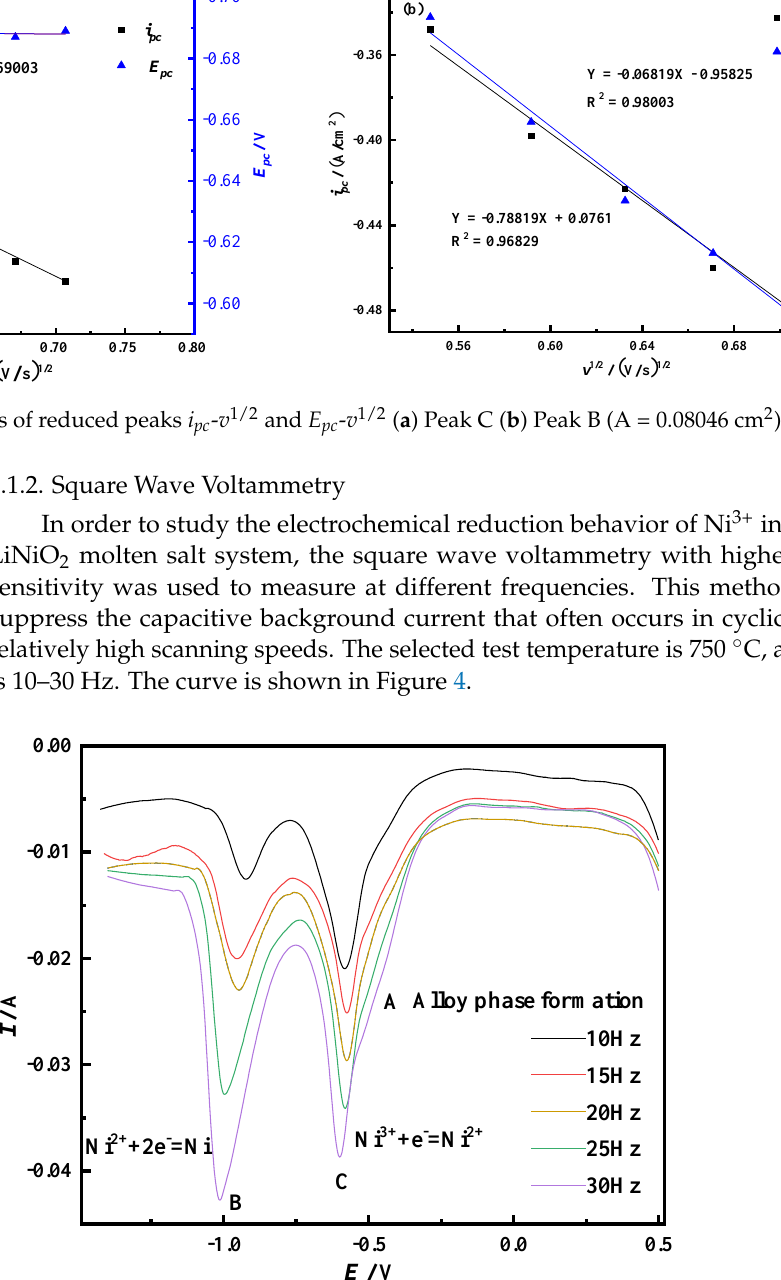
Figure 4. SWV diagram of the Mo electrode in the NaCl - CaCl 2 -LiNiO 2 system ( f : 10–30 Hz, T = 750 °C, reference electrode: Pt electrode, area = 0.08046 cm 2 ). There are three peaks A, C and B in the square wave voltammetry curve, and peak A is the alloy peak. The presence of peaks B and C indicates that Ni 3+ forms a Ni elementary substance through a two-step electrochemical reduction process, which is consistent with the results of the cyclic voltammetry